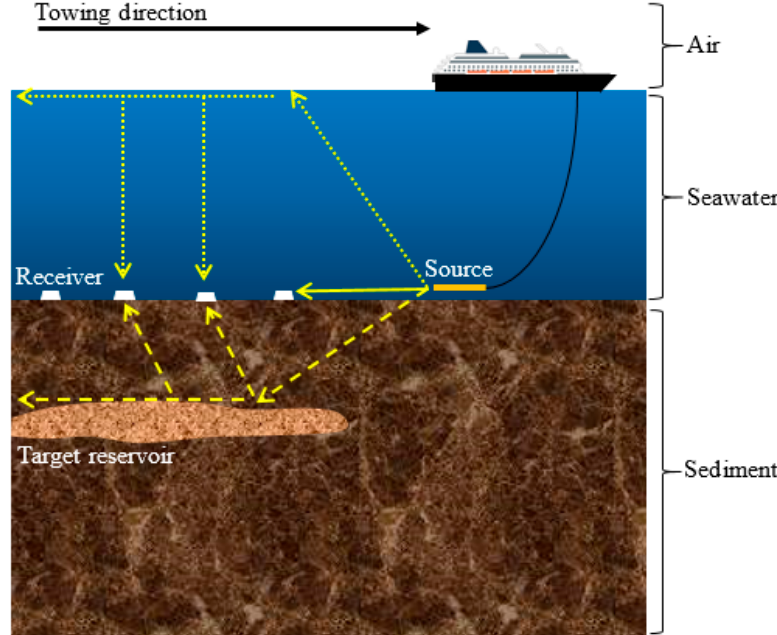
Figure 1. Basic layout of marine CSEM application in hydrocarbon exploration. The source is towed nearly to the seabed receivers. A target reservoir is expected to be embedded in the conductive sedimentary rocks. The EM signal spreads in all direction through the seawater, air–seawater interface, and sediment before being recorded by the EM receivers.